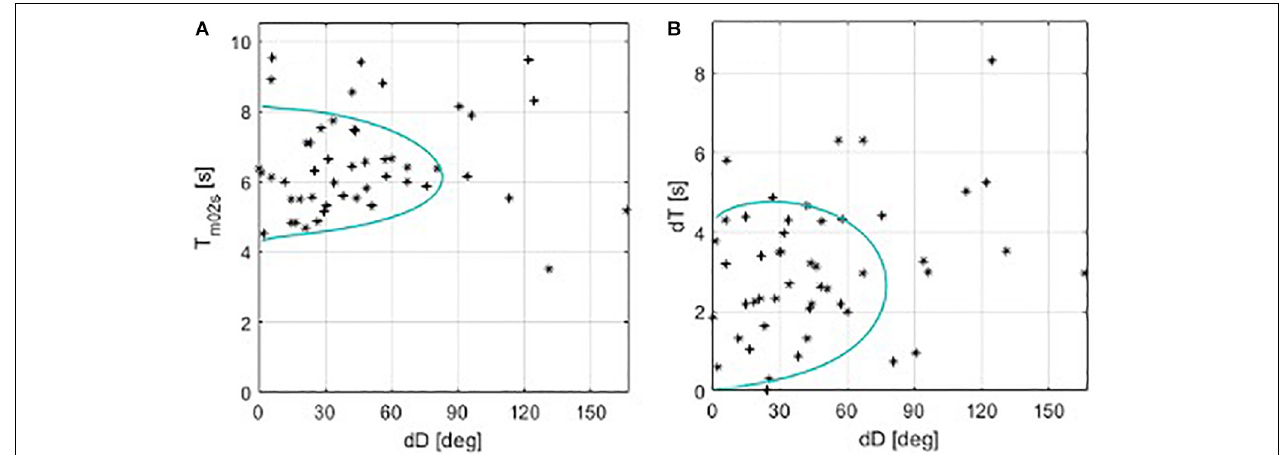
FIGURE 13 | Scatter diagram of the direction difference with the (A) swell peak period, and (B) direction difference.